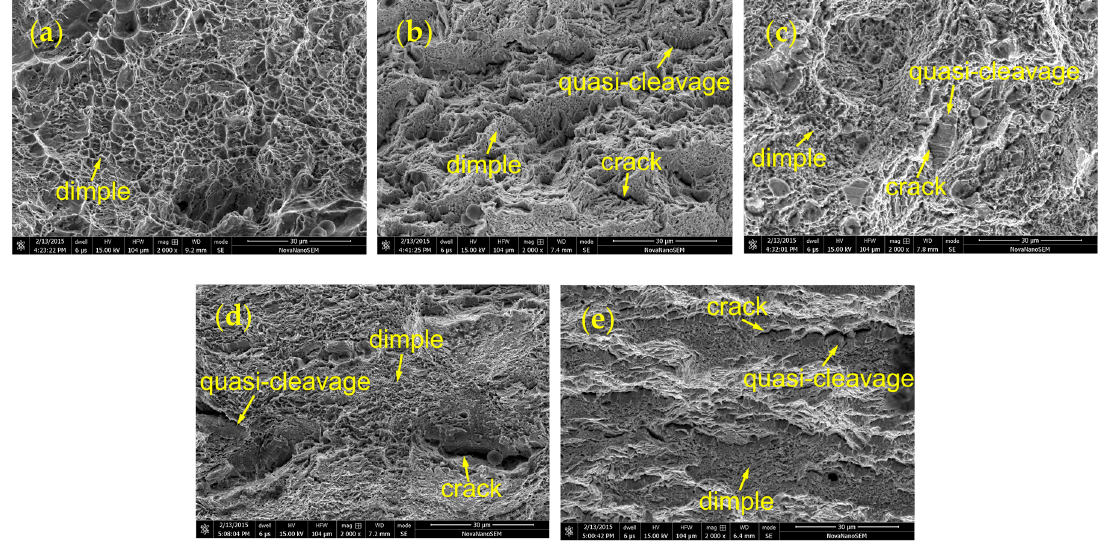
Figure 9. The fractography of tensile specimens for ( a ) BM, ( b ) HD-L, ( c ) HD-T, ( d ) CF-L, and ( e ) CF-T.